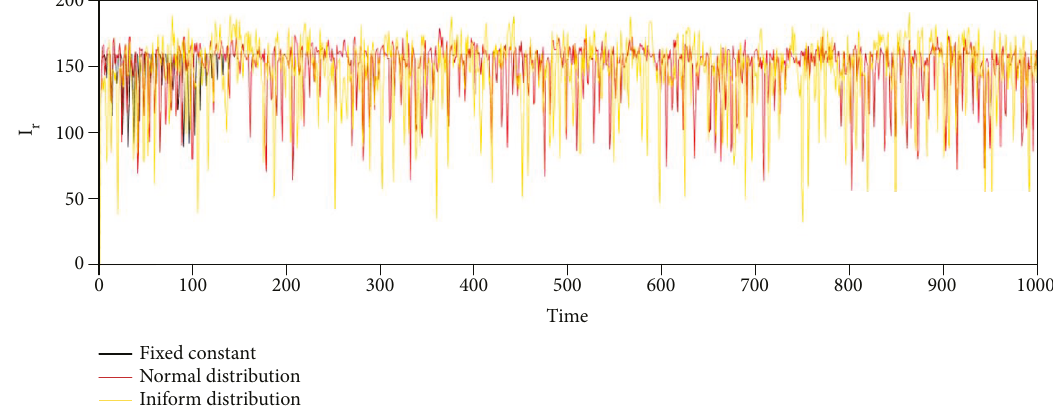
Figure 8: Retailers ’ initial inventory changes in an unstable state under three demand scenarios.